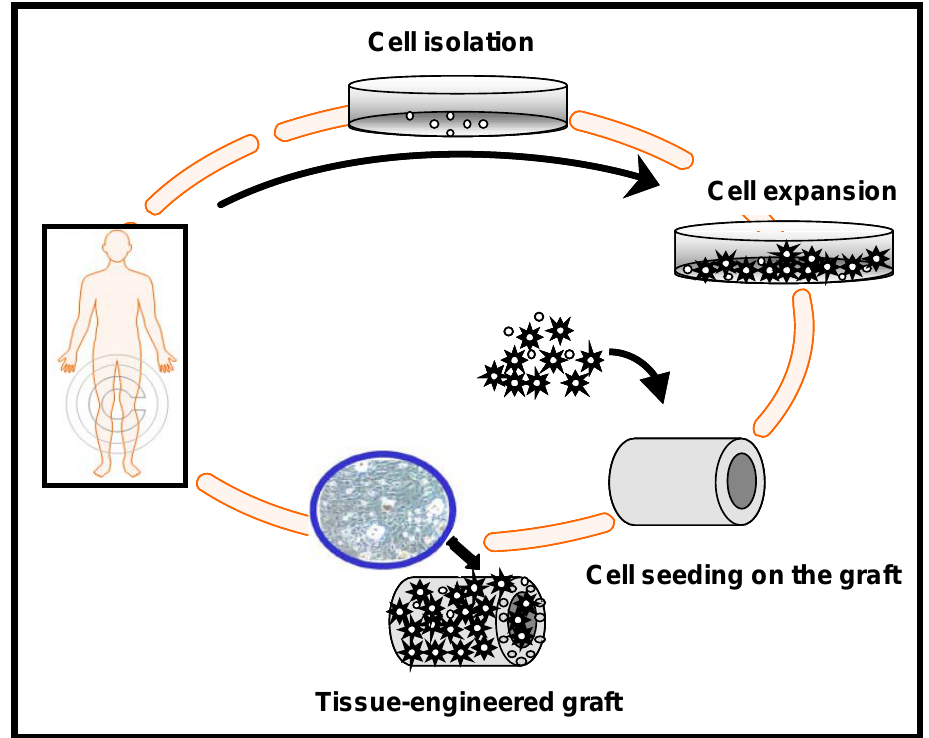
Figure 2. Tissue-engineered graft fabrication